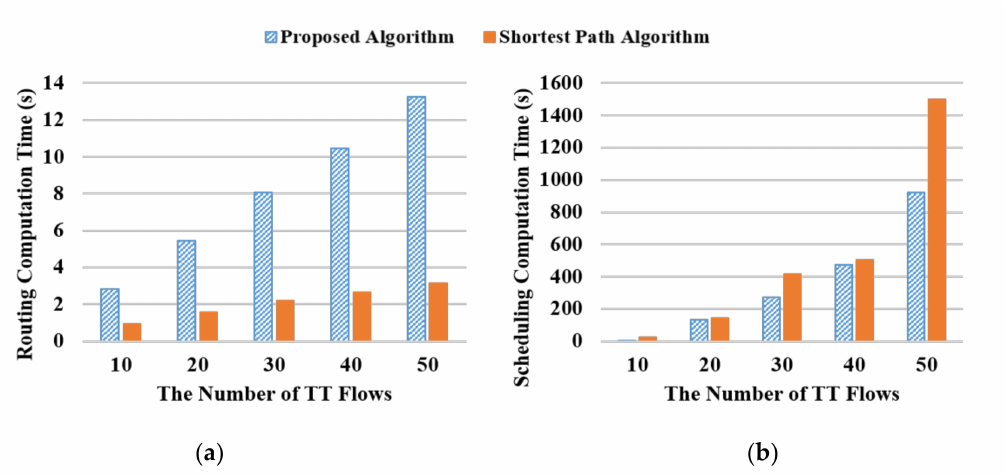
Figure 11. Computation time in ( a ) Routing and ( b )